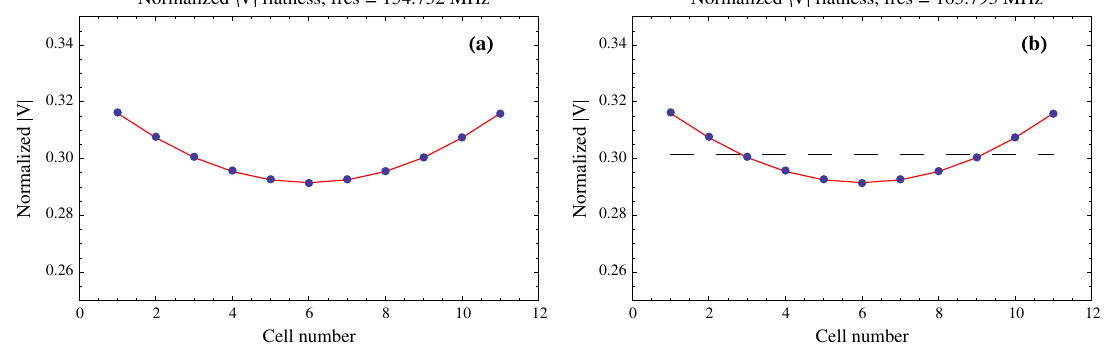
FIG. 9 (color online). (a) The red curve is the result of fitting the model to the MWS field flatness profile (blue filled dots) while keeping the resonant frequency fixed. (b) κ 1 is increased by 10 × while μ has the same value that is used to create (a). The curve from (a) is still good but the resonant frequency has shifted. The dashed line represents the case when μ ¼ 0 and shows that there is no curvature in this